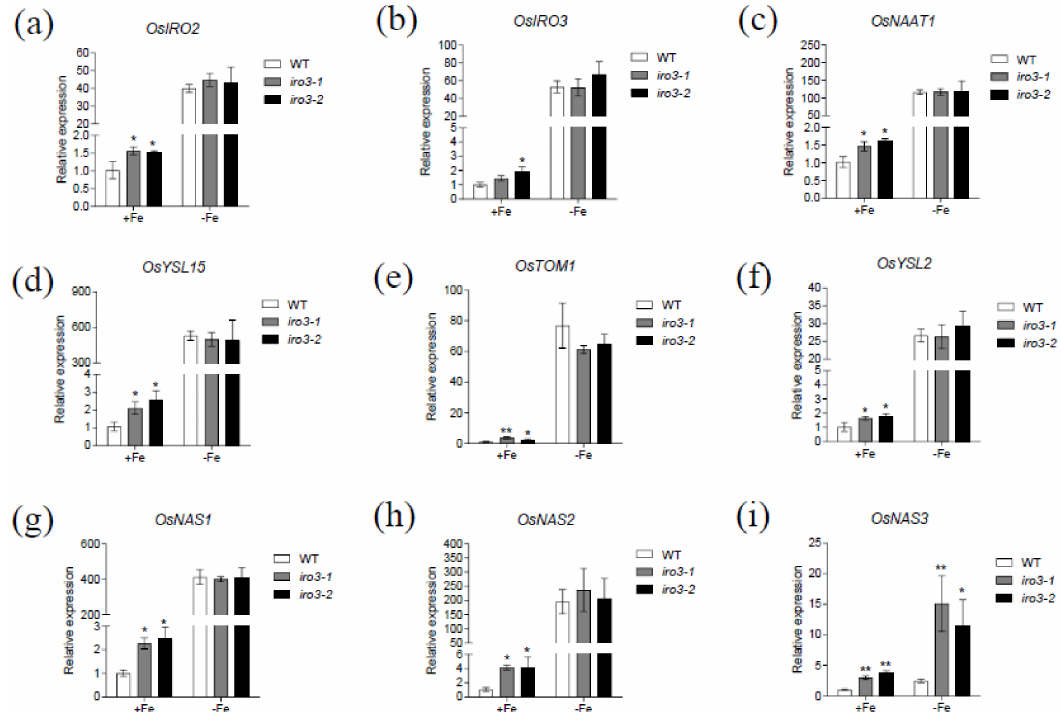
Figure 5. Expression of Fe deficiency responsive genes in the iro3 mutants. Fourteen-day-old seedlings grown in Fe-su ffi cient media were transferred to Fe-su ffi cient or Fe-deficient media for 4 days. Roots were sampled and used for RNA extraction. The expression of OsIRO2 ( a ), OsIRO3 ( b ), OsNAAT1 ( c ), OsYSL15 ( d ), OsTOM1 ( e ), OsYSL2 ( f ), OsNAS1 ( g ), OsNAS2 ( h ), and OsNAS3 ( i ) was determined by quantitative real-time RT-PCR. OsActin1 was used as the internal standard. Data are given as the means ± SD of three biological replicates. All data were compared with the WT. Significant di ff erences from the mutant and WT are indicated by * p < 0.05, ** p < 0.01, as determined by two-tailed Student’s t